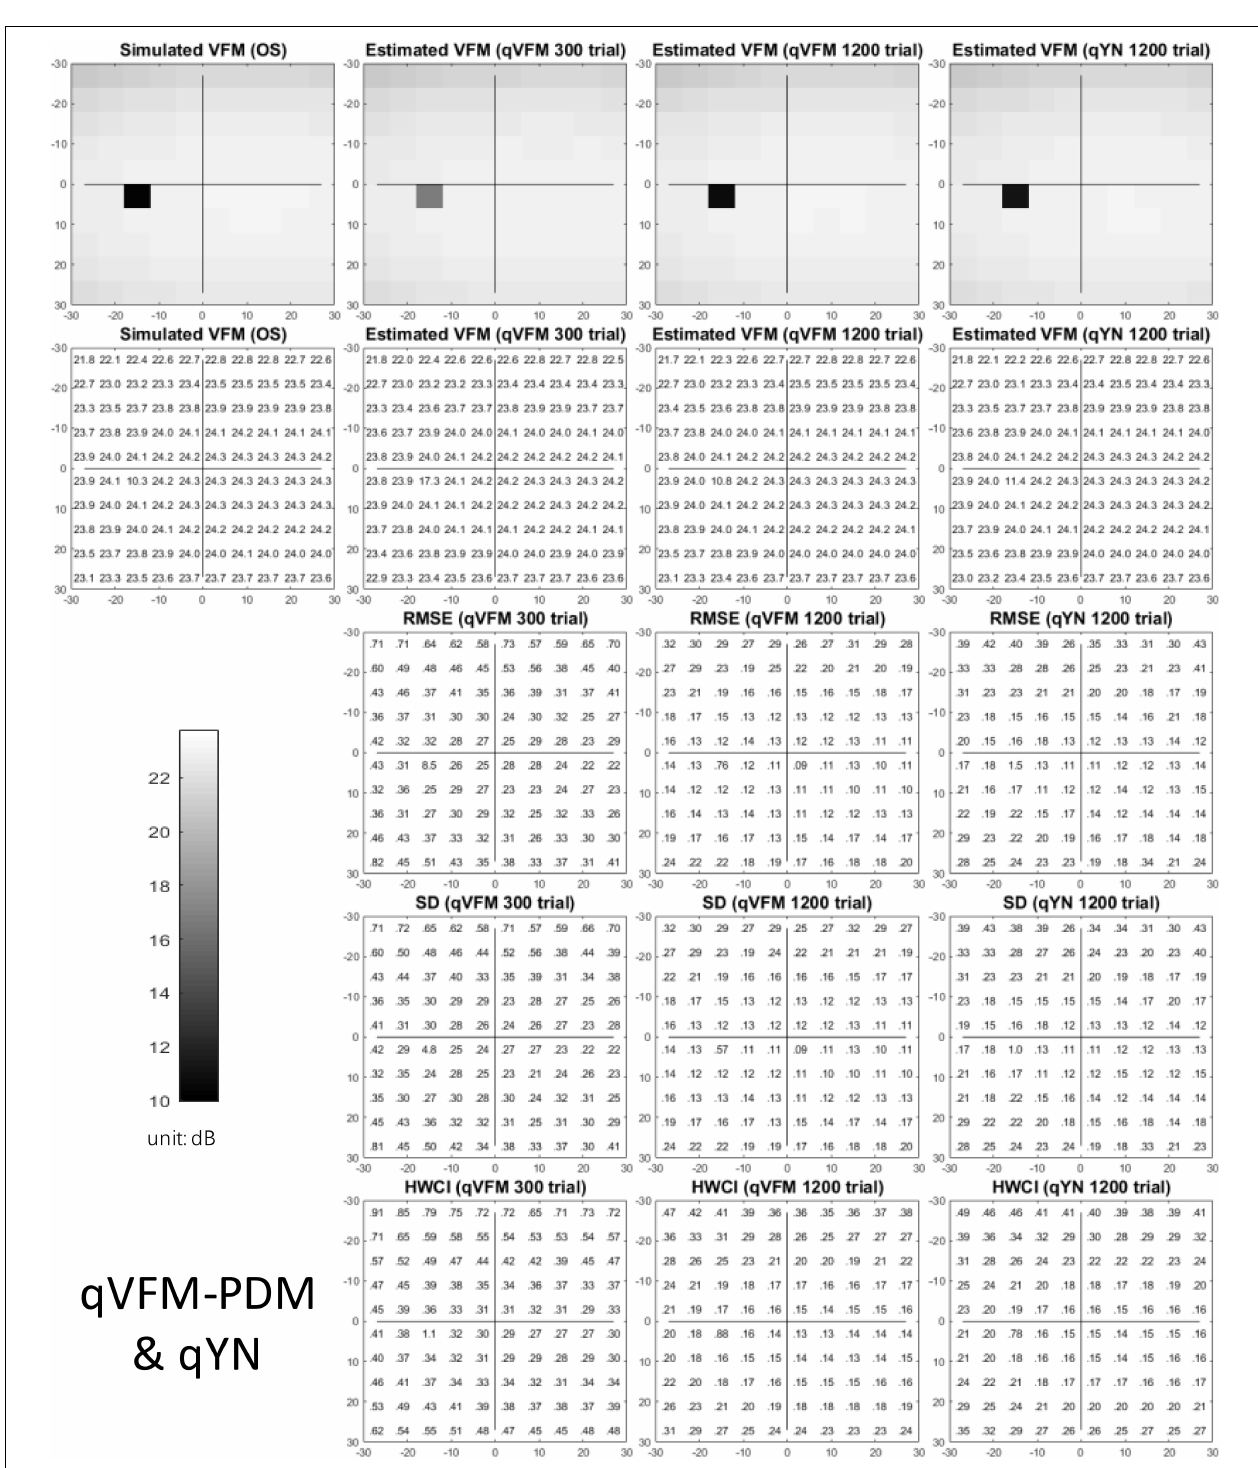
Frontiers in Neuroscience |